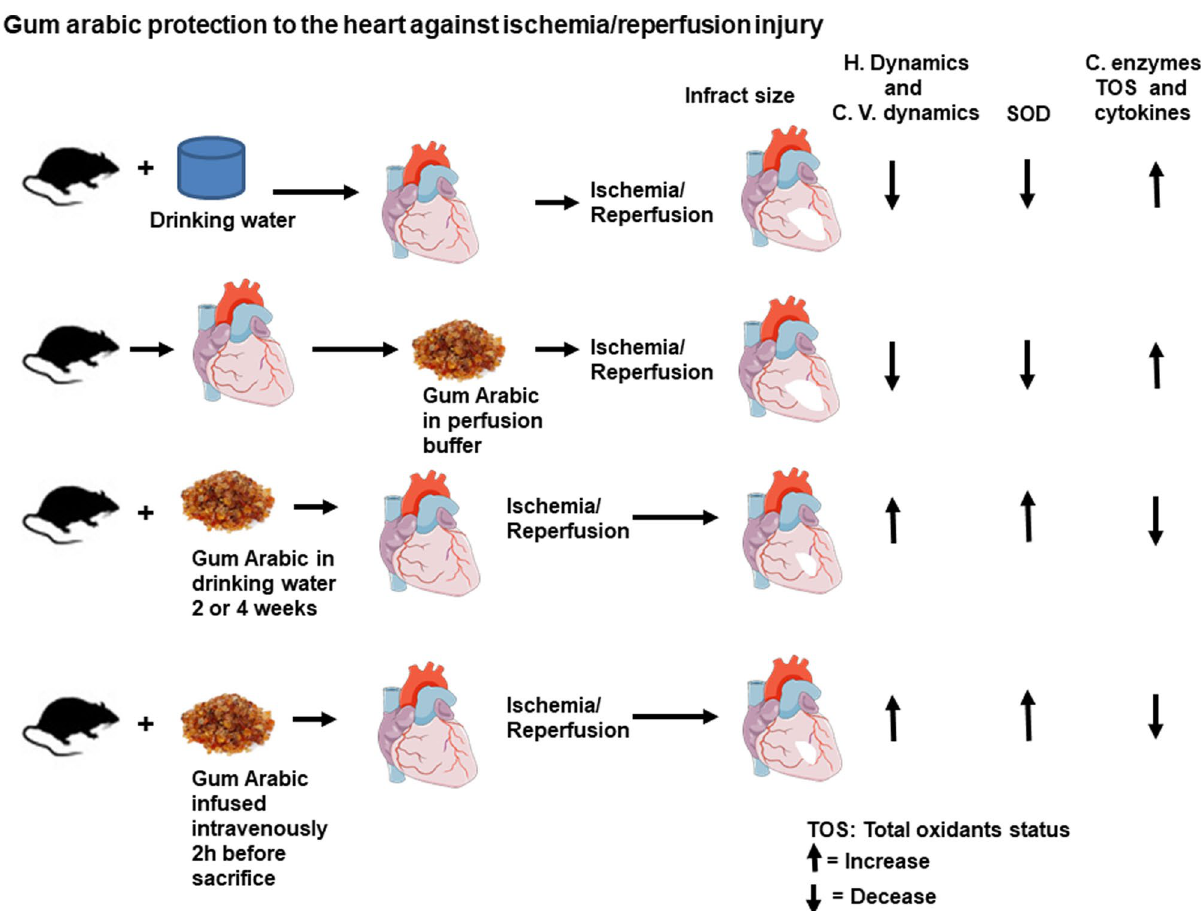
Figure 8. Schematic representation of the protective effects of GA shown in this study (n = 8 for hemodynamics and (n = 4) for infarct size, antioxidants effects and anti-inflammatory effects). Ctr control, H. dynamics hemodynamics, C. dynamics cardiovascular dynamics, C. enzymes cardiac enzymes, SOD superoxide dismutase, TOS total oxidants, GA 2 h Gum Arabic infusion 2 h before sacrifice, GA 2 W Gum Arabic administration for 2 weeks, GA 4 W Gum Arabic administration for 4 weeks, GA Rep . Gum Arabic infusion at